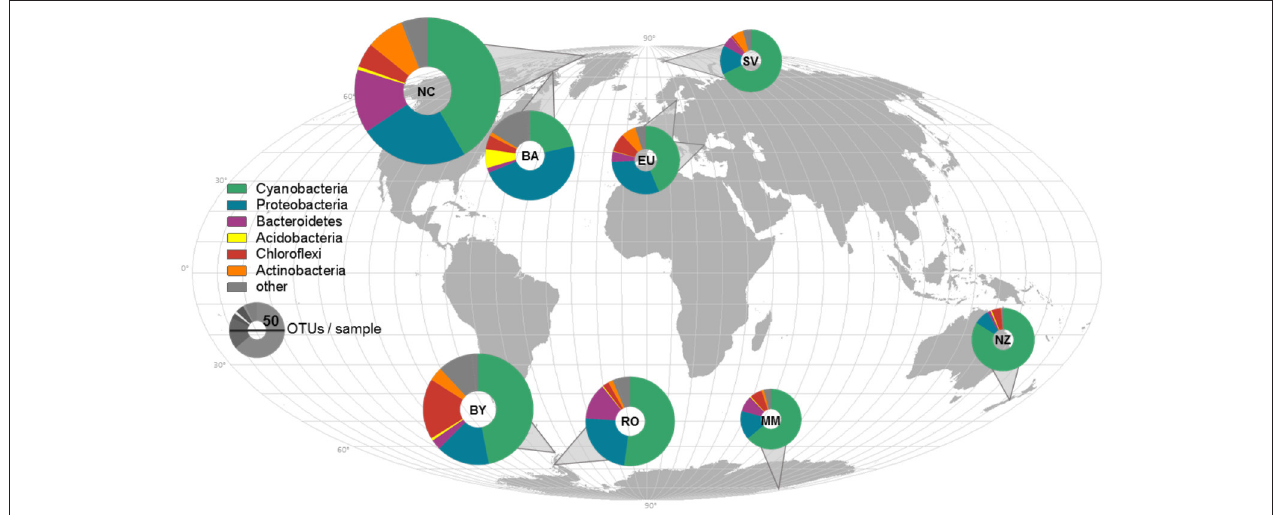
FIGURE 1 | Sample locations, average composition of phyla, and species richness displayed on a world map. The average composition of bacterial phyla for each sampling location is represented and indicated by different colors. The richness was rarefied to the smallest sample size for each location and the same number of reads and is displayed by the size of the icons. NC, Northern Canada; BA, Baffin; EU, Europe; SV, Svalbard; BY, Byers; RO, Rothera; MM, McMurdo; NZ, New Zealand.